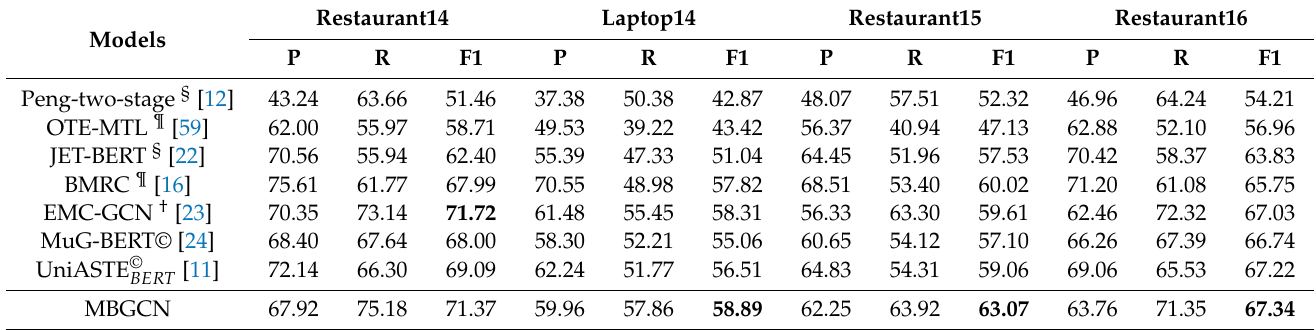
Table 4. The performance of MBGCN on V 2 . The “ § ” means the results are retrieved from [8]. The “ ¶ ” denotes the results are retrieved from